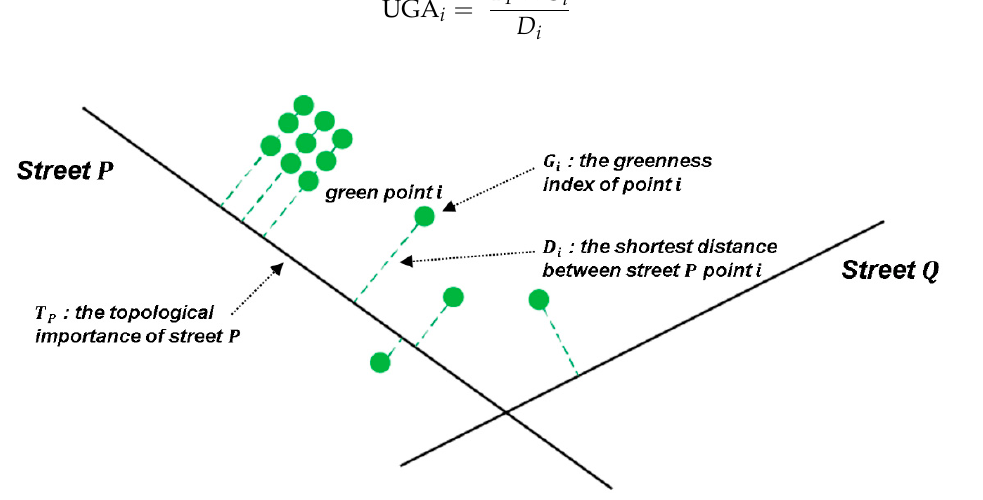
Figure 1. Access situations to green points near a street in a city.